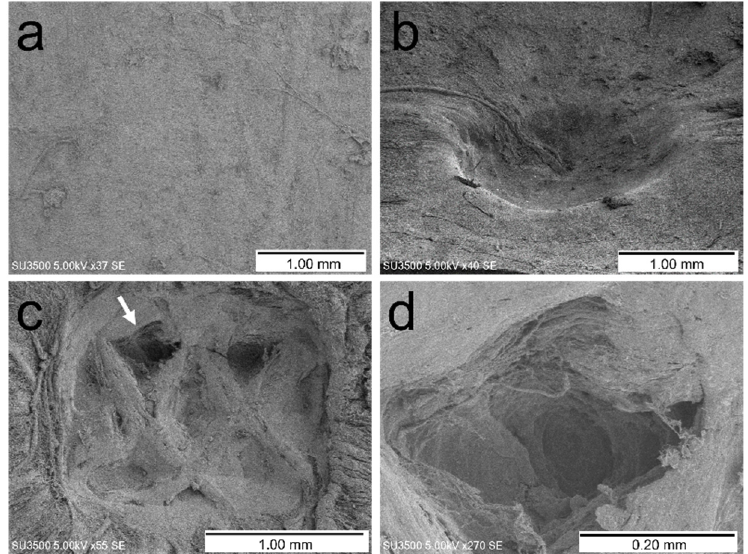
Figure 4. Examples of changes observed in the dura mater with electron microscopy. ( a ) Control. ( b ) Dural indentation (50 g load, covered with neurosurgical cotton pattie). ( c ) Dural indentation or partial non-perforating wound resembling the shape of the ultrasound tip (50 g load, uncovered). ( d ) Partial enlargement of the site indicated by the arrow in image ( c ).